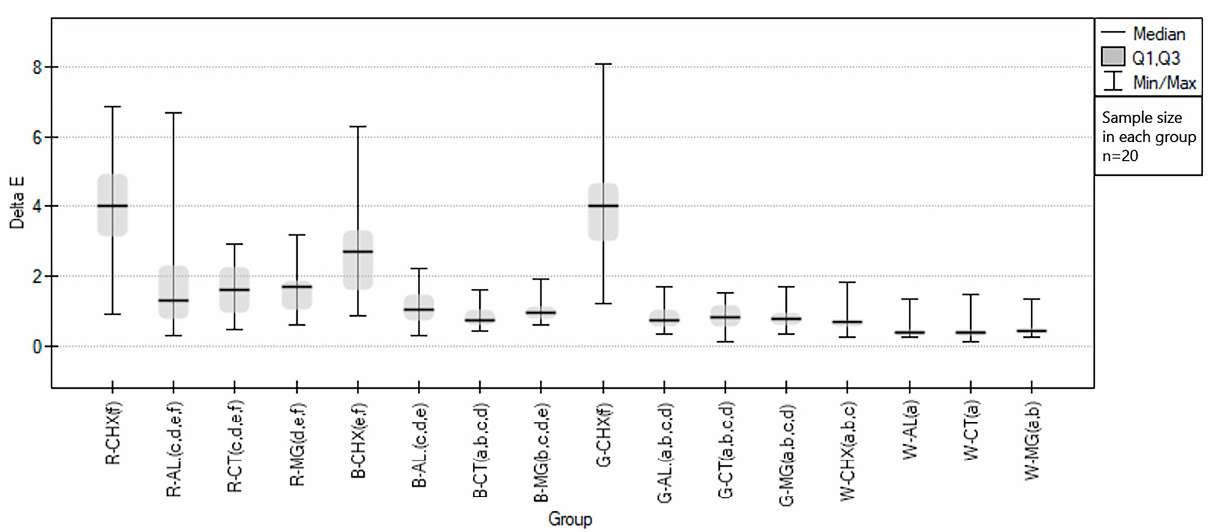
Figure 3. Graphical representation of the results of statistical analysis of the color changes of EVA samples under the influence of disinfecting materials, divided into groups ( n = 20). The lowercase letters in brackets after the group code indicate homogeneity between the groups in post-hoc Dunn– Bonferroni